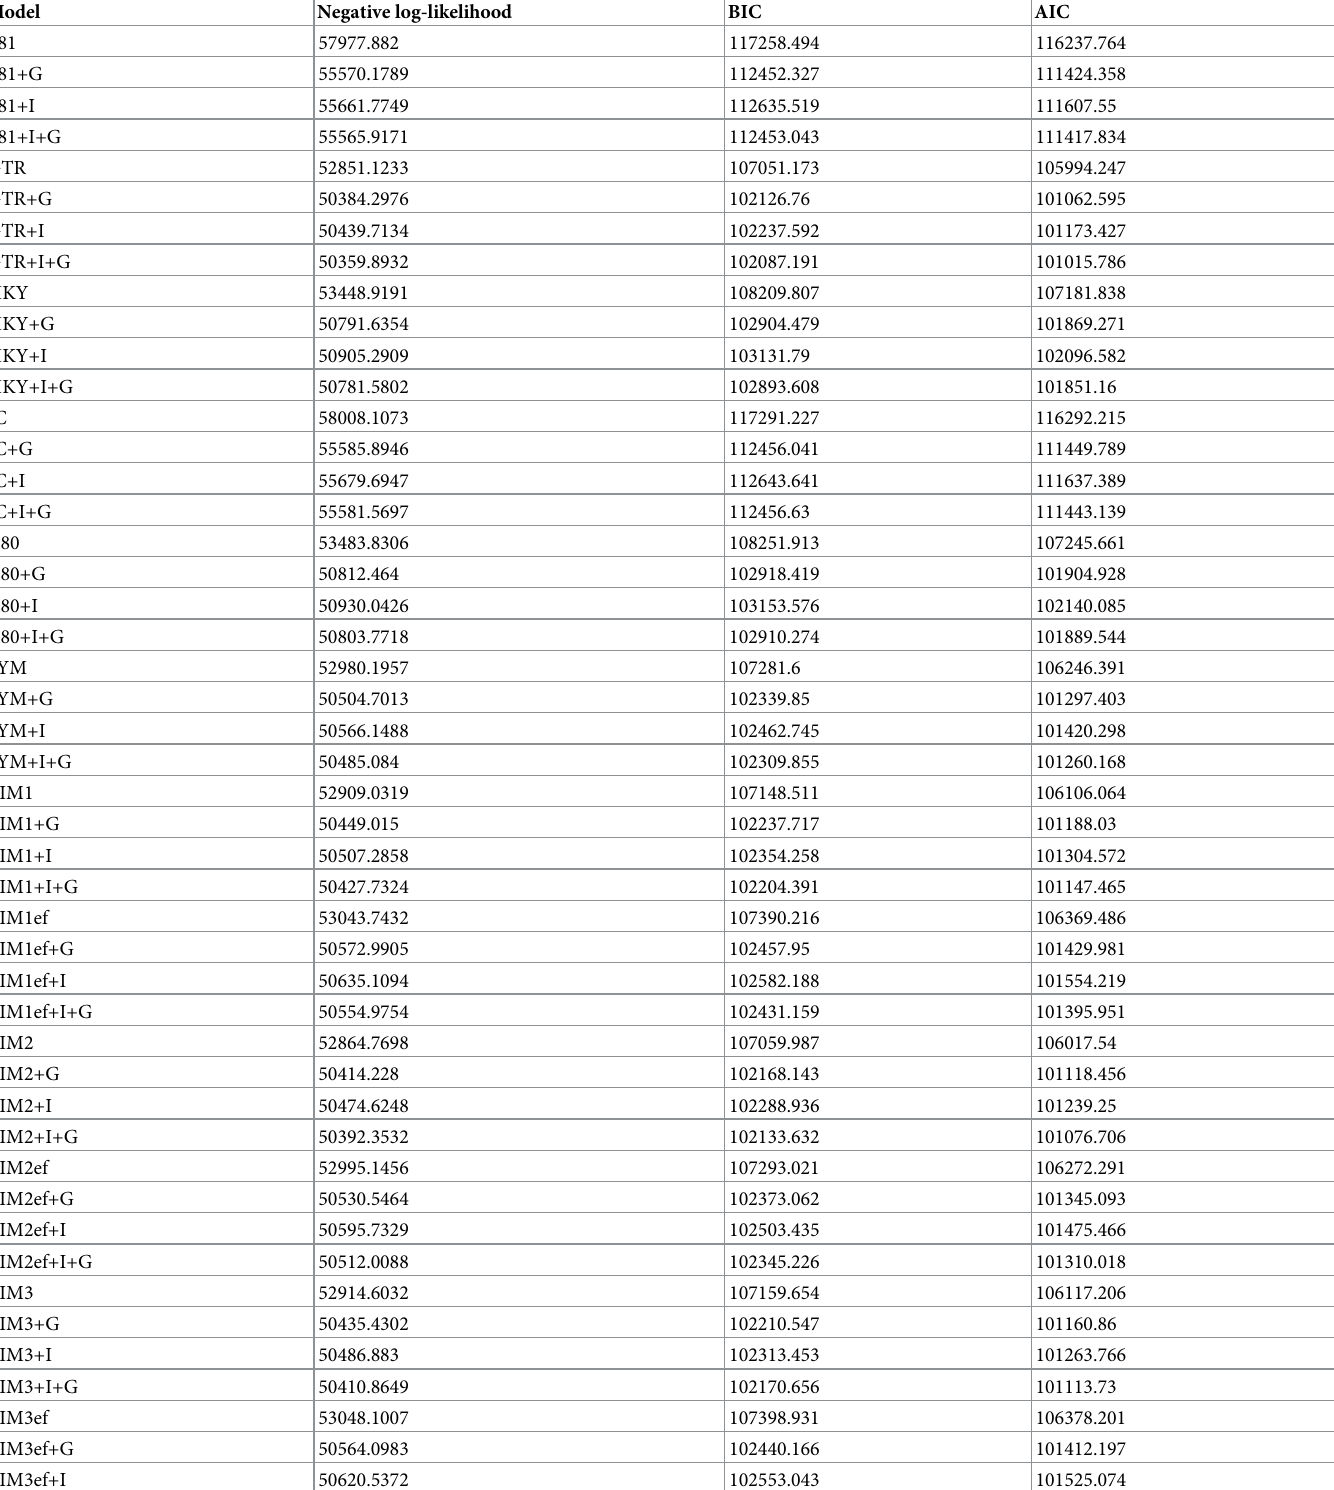
Table 3. Nucleotide Substitution Model Selection.